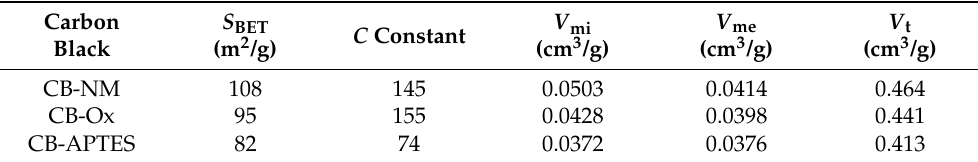
Figure 1. The nitrogen adsorption–desorption isotherms and pore size distribution curves for carbon black samples. Table 2. Surface area and pore volumes of the carbon black samples.